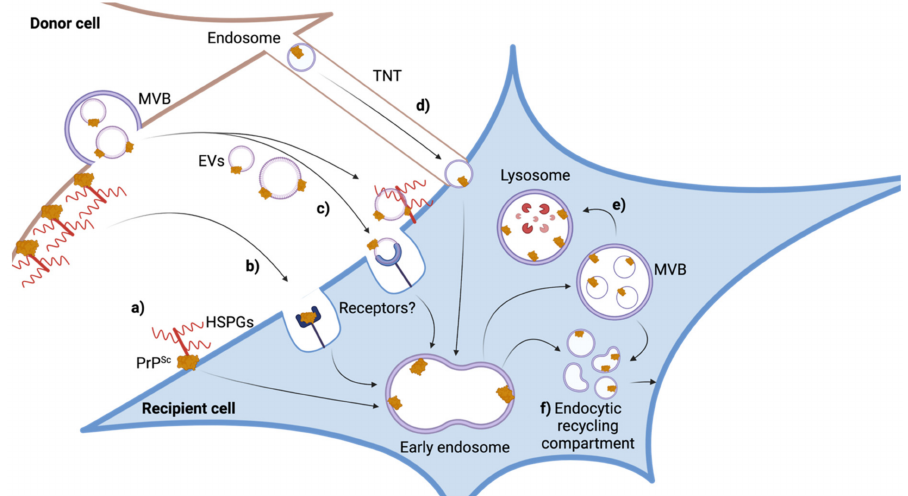
Figure 1. Prion infection mechanisms. Dissemination of PrP Sc relies on different routes. PrP Sc can be transmitted from a donor (brown) to a recipient (blue) cell. Most studies on prion uptake and infection have been performed with purified PrP Sc or with crude brain homogenate containing prions. If PrP Sc is “freely” released into the extracellular space is unknown. ( a ) Receptors for exogenously added PrP Sc include heparan sulfate proteoglycans (HSPGs), Lrp1 or the 37 kDa/67 kDa laminin receptor (LRP/LR). ( b ) “Free” PrP Sc can be internalized by different endocytosis routes or macropinocytosis. ( c ) In cellular systems, PrP Sc can be released from donor cells via microvesicles shedding from the cell surface or in association with smaller extracellular vesicles (EVs) derived from multivesicular bodies (MVBs) that fuse with the cell membrane. EVs can be taken up by recipient cells by different pathways. Few EV ligands that mediate binding to target cells have been identified.